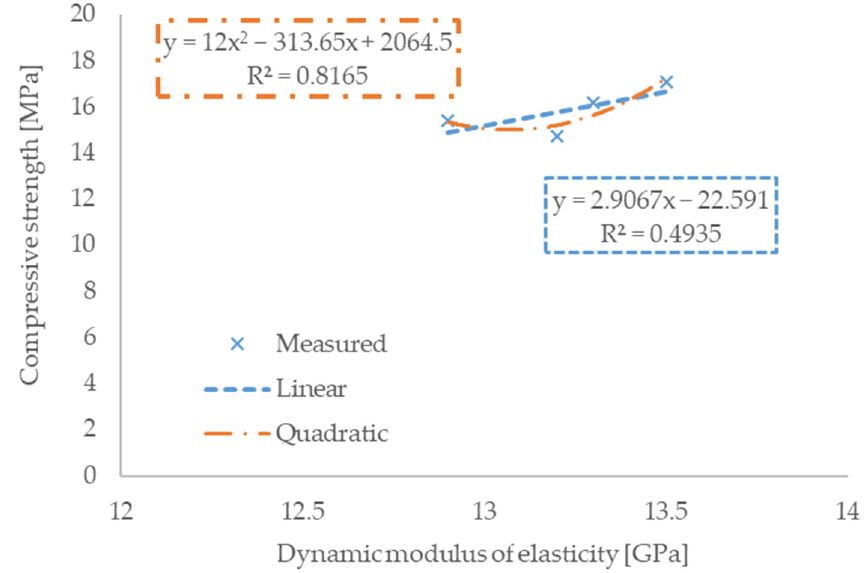
Figure 3. The relationship between dynamic modulus of elasticity and compressive strength.